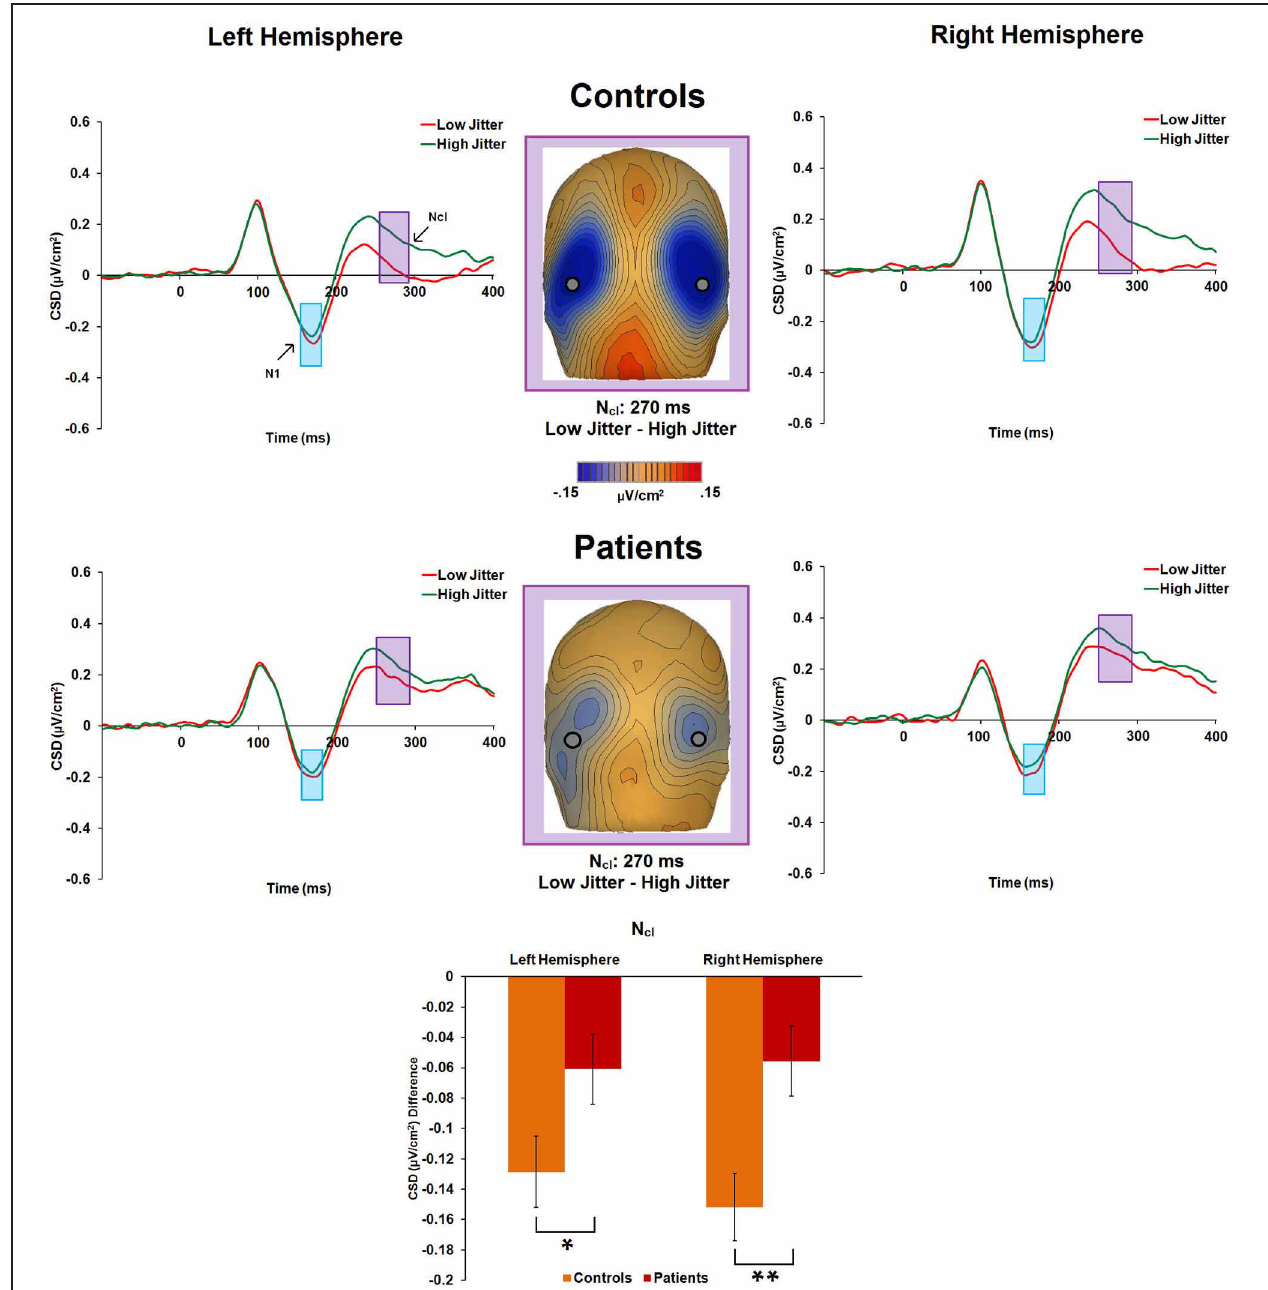
FIGURE 5 | Event-related potential CSD responses to low- and high-jitter stimuli from occipital electrodes (right hemisphere: P8, PO8, PO10; left hemisphere: P7, PO7, and PO9) in controls and patients. CSD waveforms show a small difference in response to low- versus high-jitter for the N1 component (blue shaded window) and a much larger difference between conditions for the N cl